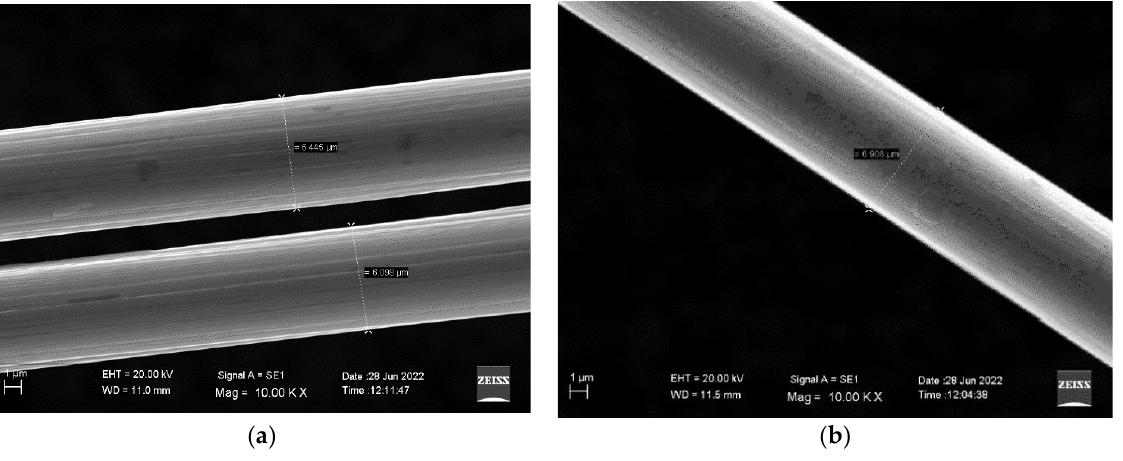
Figure 9. SEM analysis on carbon fibers: ( a ) 1R and ( b ) 2R. Table 3. Carbon fiber diameters by SEM.